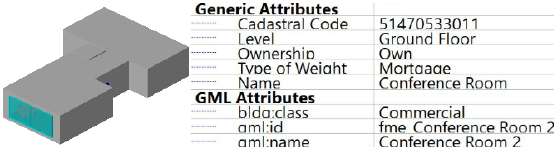
Figure 9: Legal properties transferred from IFC to CityGML LoD 4